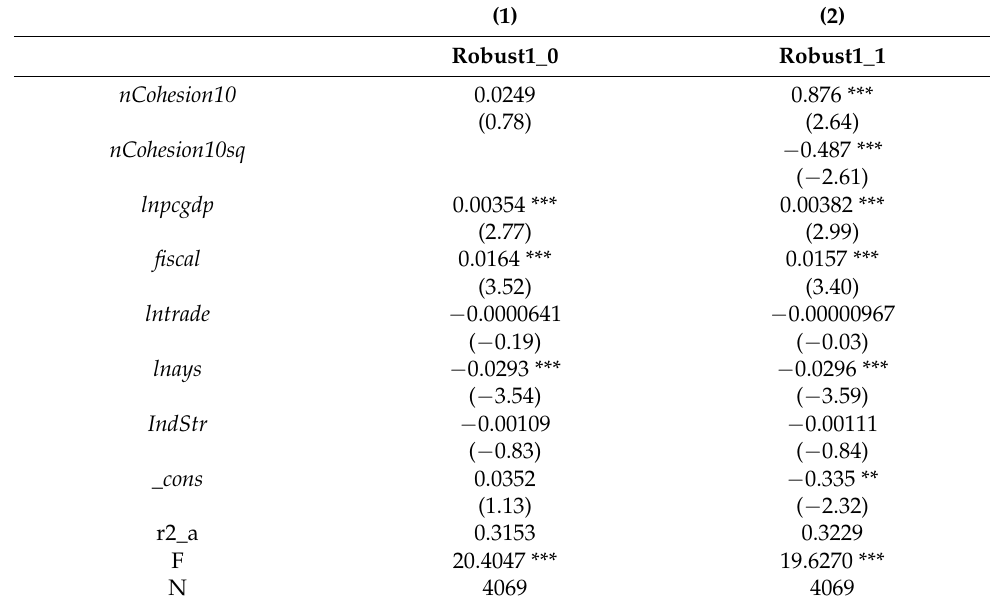
Table 7. Robustness tests: impact of city shape on urban poverty (excluding